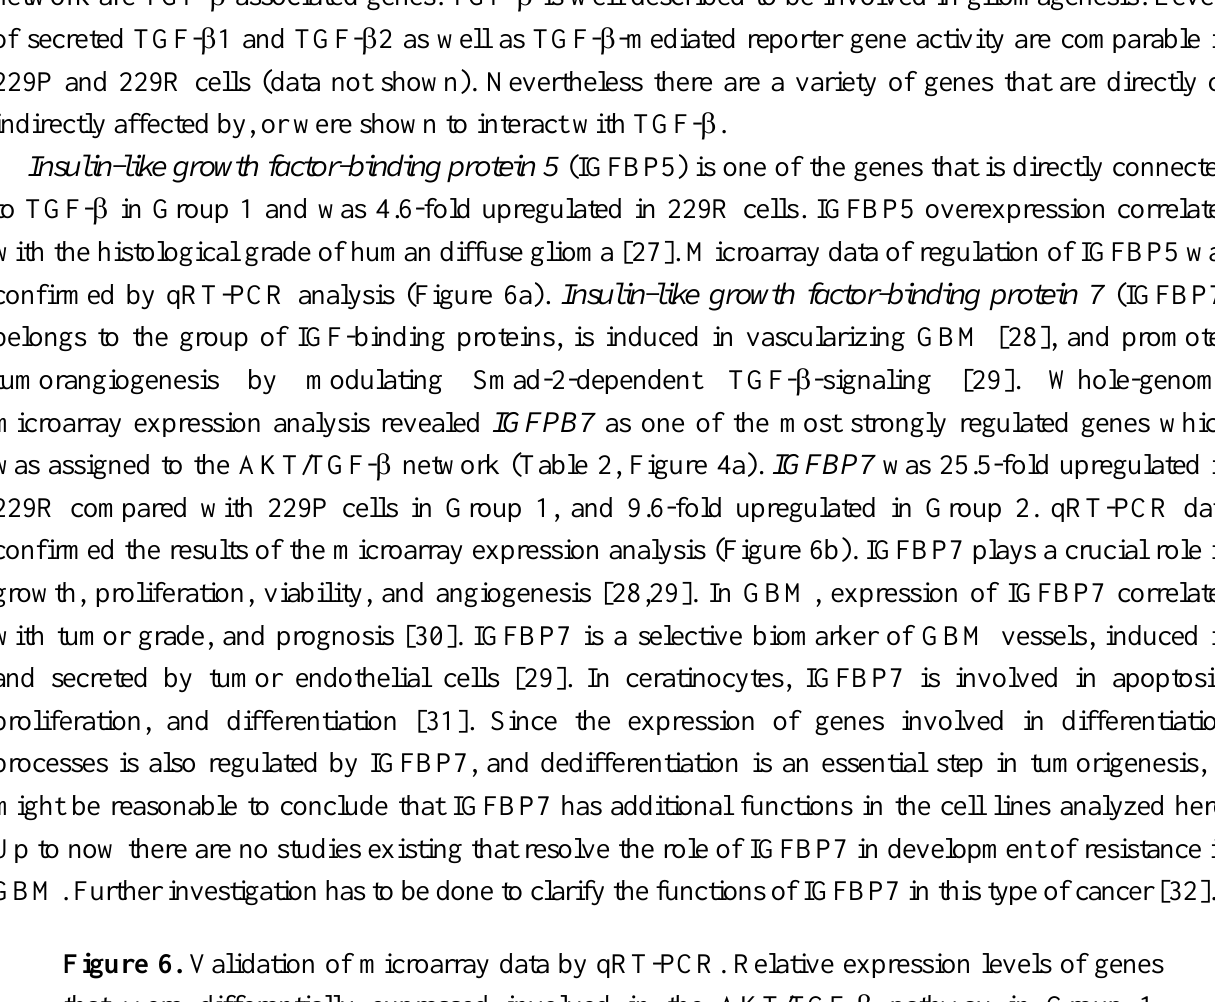
Figure 6. Validation of microarray data by qRT-PCR. Relative expression levels of